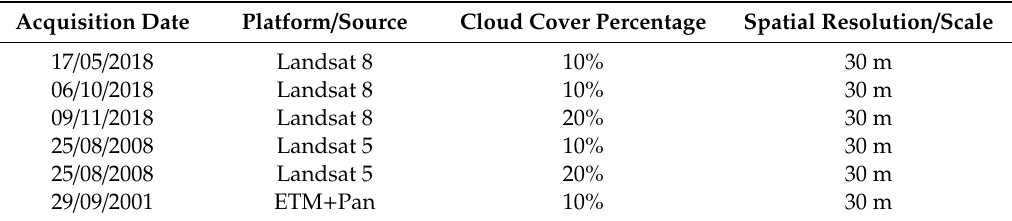
Table 4. Information on the satellite imagery used in the Vietnamese case